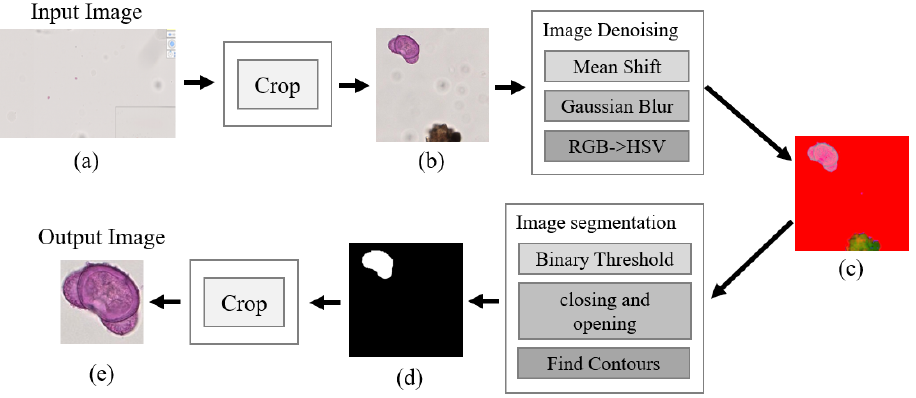
Figure 2. The overall pipeline for pre-processing: ( a ) the input pollen scanning image; ( b ) the rectangular image after cropping; ( c ) the resulting image after denoising and the conversion of the color space from RGB to HSV; ( d ) the mask that was generated by the segment operators; ( e ) the output image that was cropped from the rectangular